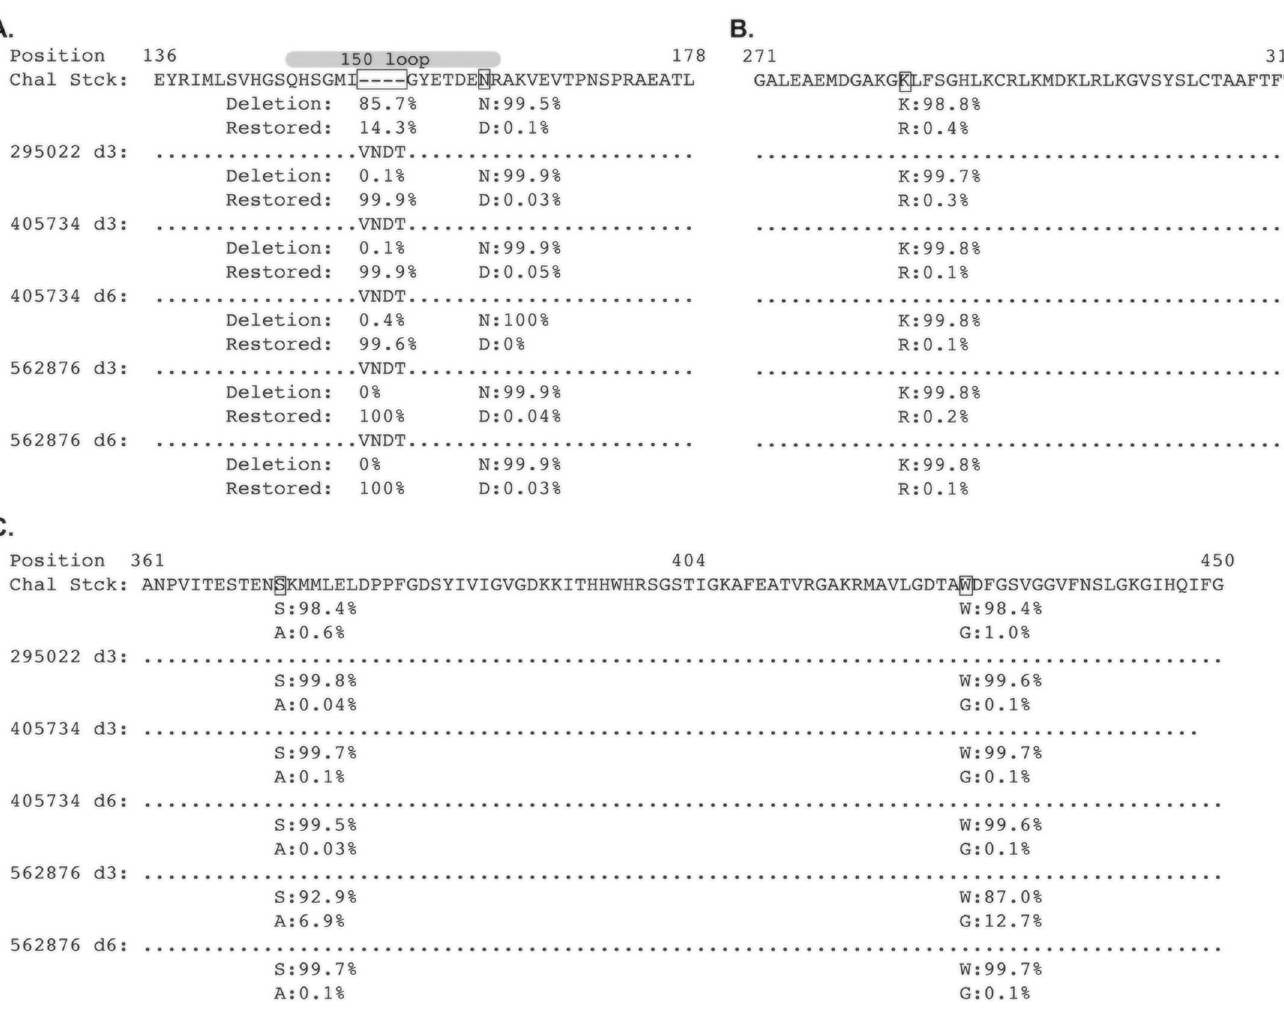
Fig 3. An N-linked glycosylation site in envelope is rapidly selected in vivo. Envelope sequencesfrom the three animals were sequencedat three days post infection, and from two of the animalsat day six post infection. A Muscle alignmentof the translated sequenceswas generatedin Geneious. Dots represent identity to the consensussequence.Dashes represent deletions. Capitalletters representamino acids. Only regions of the E protein with sequencevariants are depicted. A. E protein amino acid positions136–178.The frequenciesof the deletionand the restored deletionare shown below each of the stock sequences, with the indicatedsite boxed. Amino acid variant frequenciesmatching the variant sites in Fig 1A are shown. The gray ellipse abovethe sequencealignment represents the 150 loop of the E protein [20]. B. E protein amino acid positions271–313. C. E protein amino acid positions 361–450. There were two additionalnonsynonymous variants at greater than 5% in animal 562876at day three, and the frequency of the amino acid variants from the other animalsand time points are shown below each